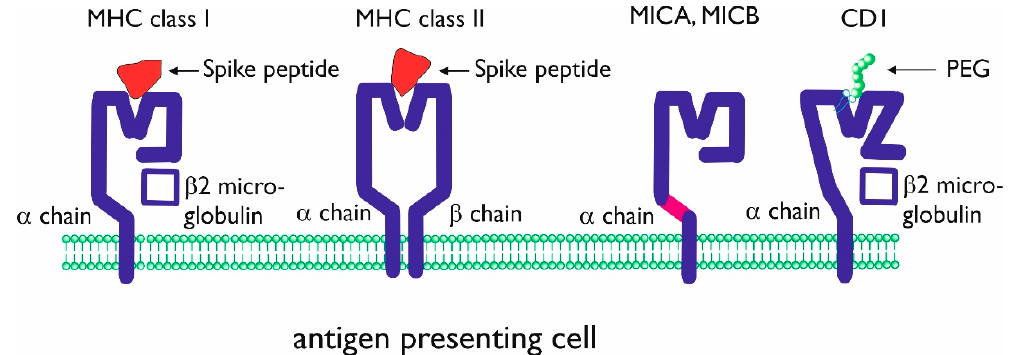
Figure 1. Schematic presentation of conventional and non-conventional antigen-presenting molecules major histocompatibility complex (MHC) class I and class II. The molecules are shown with (different) Spike peptides in the antigen-presenting groove. MHC class I-related molecules A and B (MICA, MICB) and CD1 are non-conventional antigen-presenting molecules consisting of a single α chain. The purple domain in the MICA, MICB α chain can be cut by metalloproteases, resulting in soluble MICA and MICB. CD1 is composed of an α chain, associated with β 2 microglobulin. CD1 can present lipid antigens and (potentially) lipid-bound polyethylene glycol (PEG).